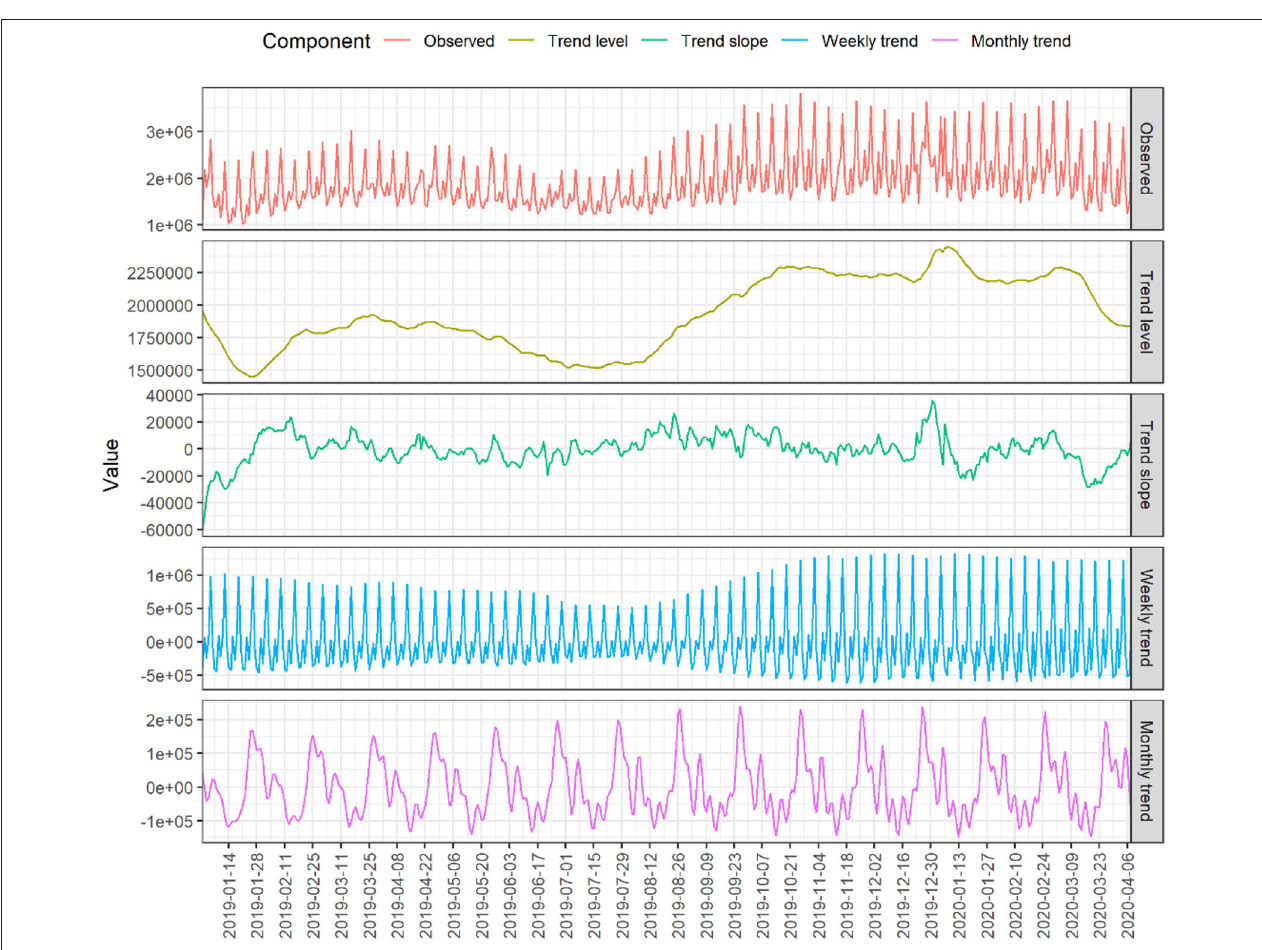
FIGURE 1 | Observed time series and TBATS-derived components. For visualization purposes, Box-Cox transformation was suppressed (in order to preserve raw numbers) and trend included manually. Actual forecast models used AIC to select best specification. Displayed dates grouped into 2-weeks